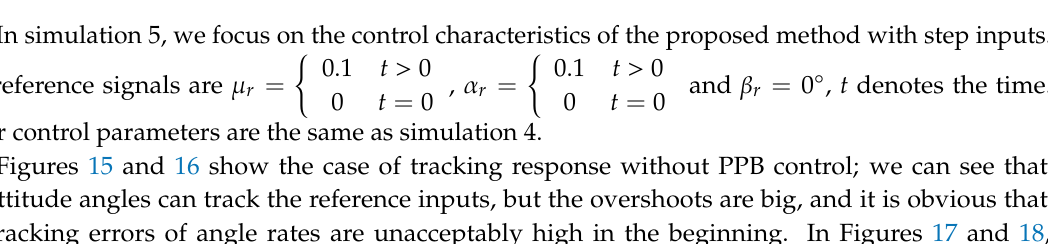
Figure 15. Tracking response of  ,  and  without PPB. Figures 15 and 16 show the case of tracking response without PPB control; we can see that the attitude angles can track the reference inputs, but the overshoots are big, and it is obvious that the tracking errors of angle rates are unacceptably high in the beginning. In Figures 17 and 18, the outputs can track the reference inputs much better than Figures 15 and 16 because of the PPB control. This indicates the effectiveness of the PPB control with the step inputs.